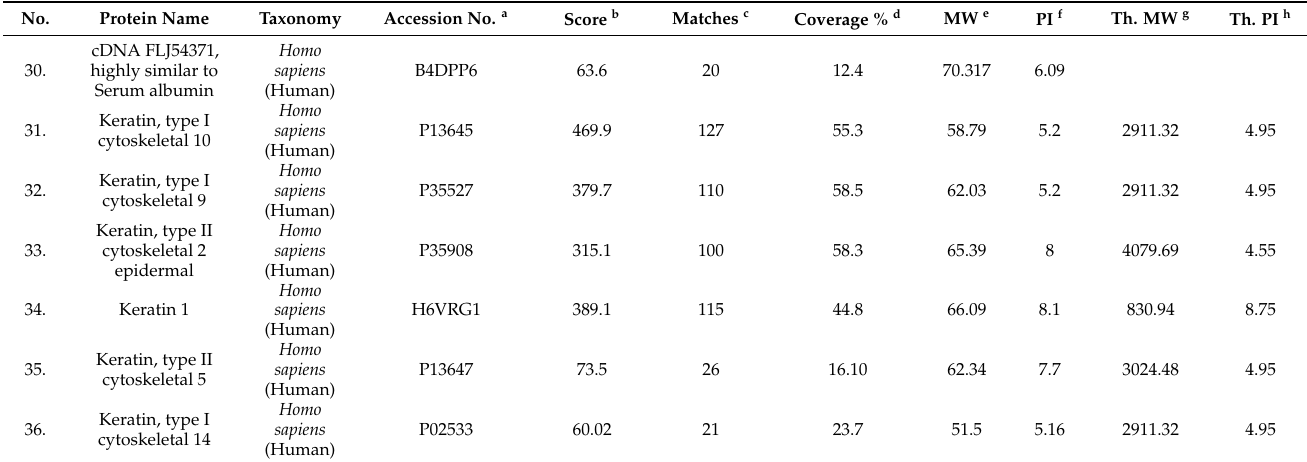
Table 3. Characteristics of identified proteins in MCF-7 cancer cells treated with DOX using 1DE.